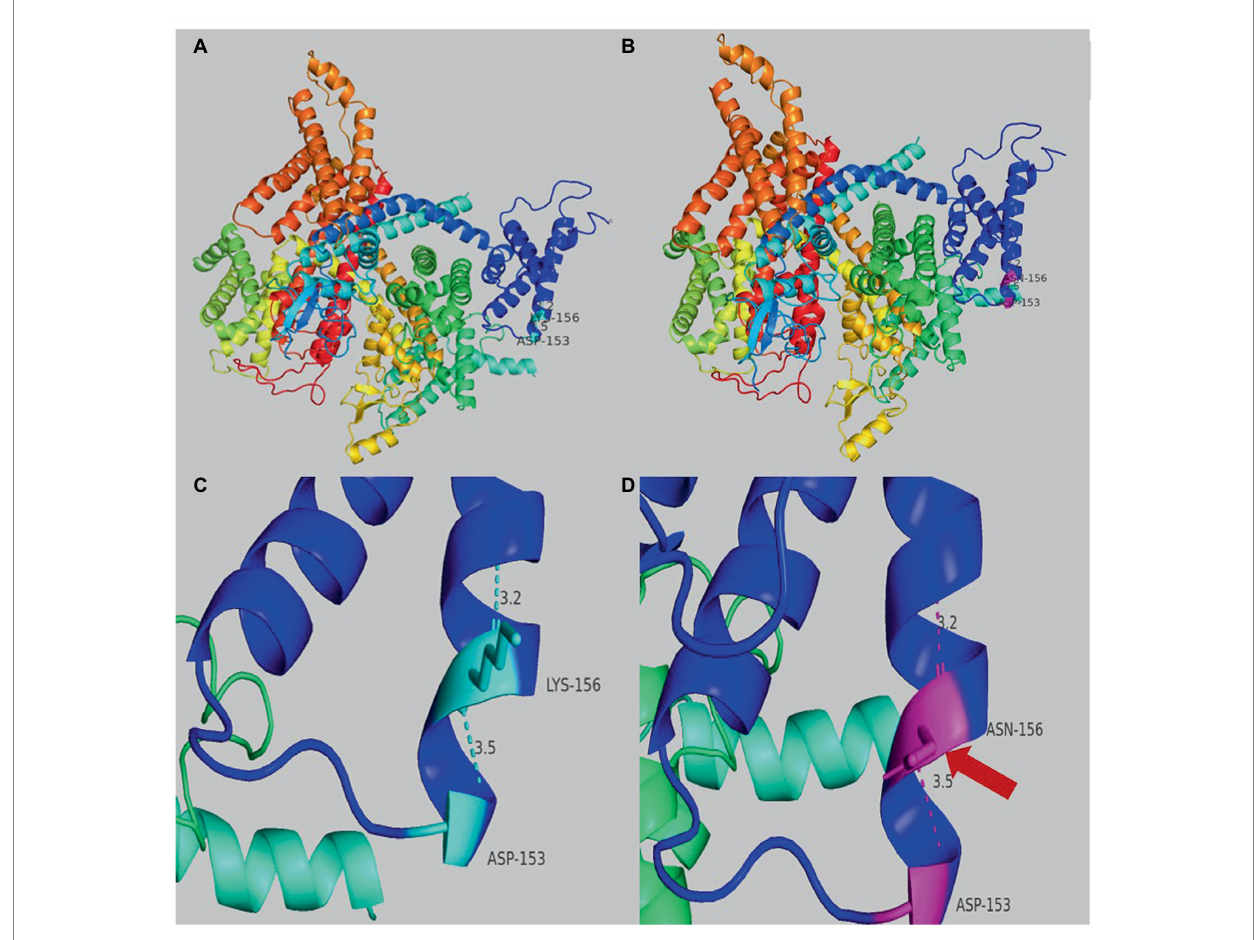
FIGURE 3 (A) Overview of the three-dimensional structure of the SCN2A wild-type protein. (B) Overview of the three-dimensional structure of the SCN2A K156N variant protein. (C) Details structure of the SCN2A wild-type protein around the mutated site. (D) Details of the SCN2A K156N variant protein around the mutated site. The red arrow indicates the difference between wild-type and variant protein residues.